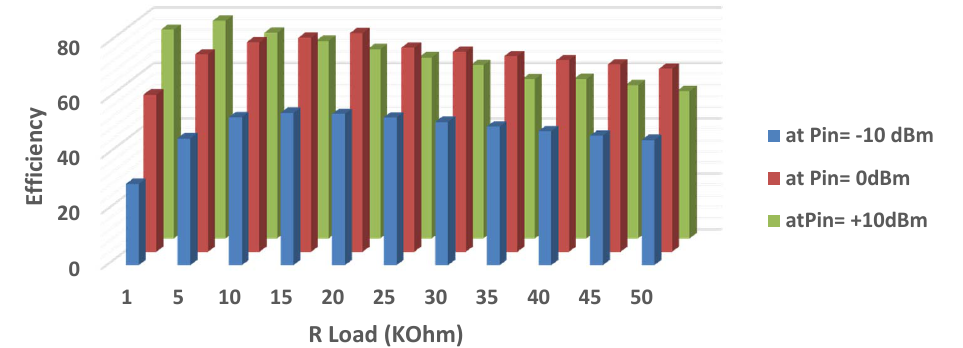
Figure 24. A chart for the conversion efficiency for the quad band vs. load variation. Based on the number of the utilized frequency bands, the proposed work harvests the number of bands more than the published results [3,52,55,57–59,61,69,74,78]. On the other side, the proposed design achieved conversion efficiency higher than the reported in [52,55,57,59,61,69,74,78] whereas it is close to the reported in [3]. Moreover, in [66], the efficiency is 40% if there is a single frequency incident upon the antenna. The efficiency is doubled when there are 4 frequencies whereas in our work the efficiency is nearly stable. It is 80% when there is a single frequency available as shown in Figure 23. Furthermore, in [67] the measured results showed that the maximum harvested DC power in typical outdoor and indoor environments was 26 µ W and 8 µ W, respectively. This comparison clearly shows the importance of this work since the conversion efficiency and output power have been enhanced beside the number of harvested frequency bands. In our study, the output power is 2 mW = 2000 µ W, as shown in Figure